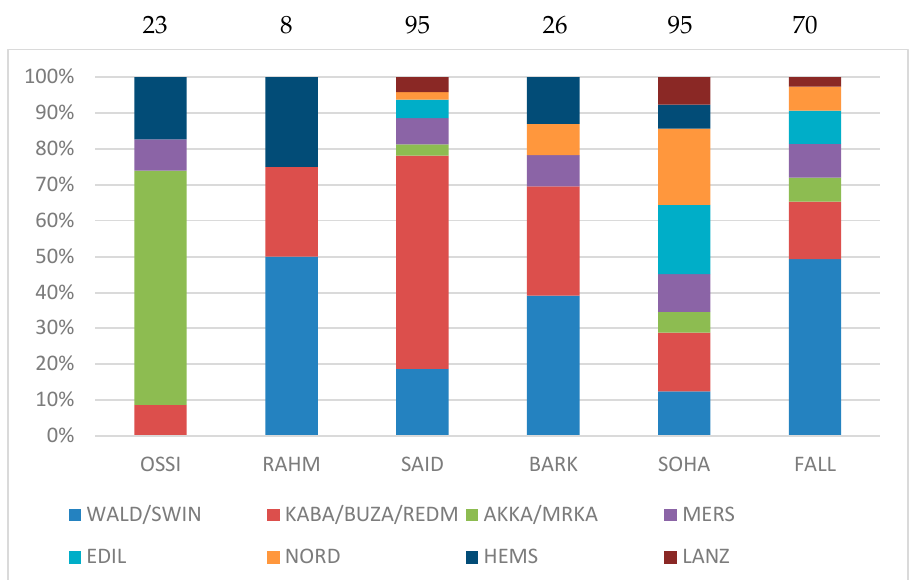
Figure 3. Type-2 connections between Egyptian and other breeds (77% of the total links were retained). The results are given in percentages but the sum of links for each breed is written at the top of each bar. The four-letter code of each breed is the same as in Table 1.